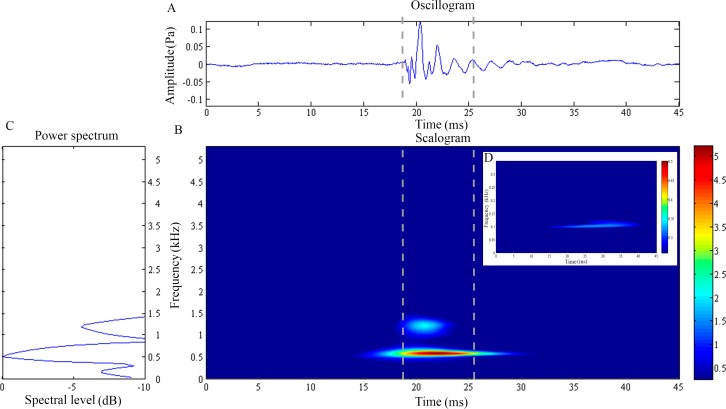
Wavelet analysis results of the feeding click produced by Doryichthys martensii.(A) Oscillogram, (B) scalogram (C) energy spectral density and (D) low frequency component of the feeding clicks produced by Doryichthys martensii. Vertical lines in (A) and (B) indicate the measured signal duration.